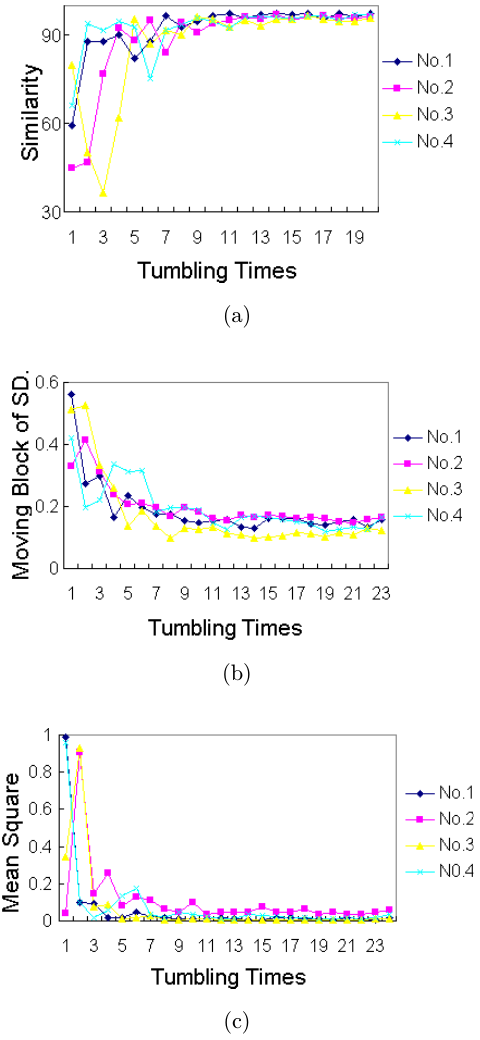
Fig. 5. Similarity (a), moving block values (b) and mean square (c) pro¯les of four di®erent coptis samples as a function of tumbling times.